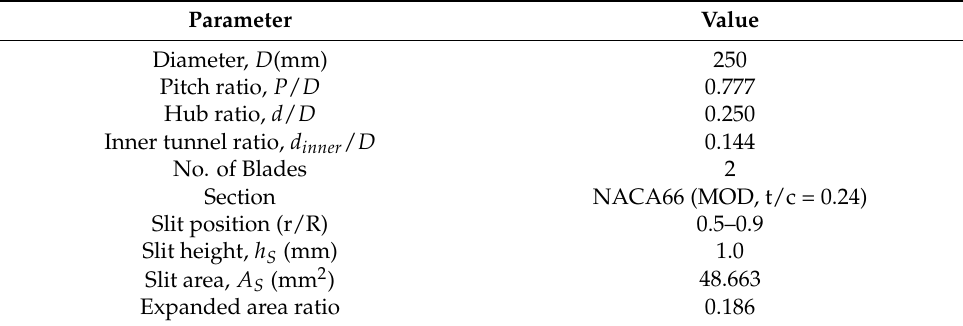
Table 1. Parameters of the Coanda propeller used in the